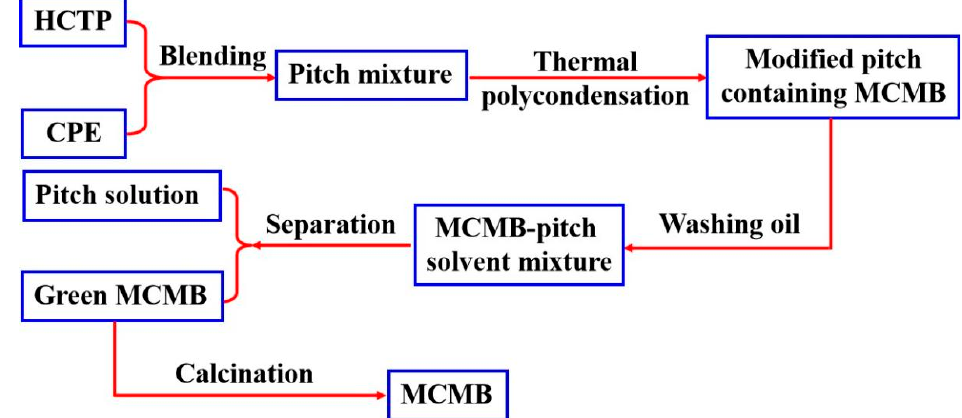
Figure 1. The preparation process of MCMBs.